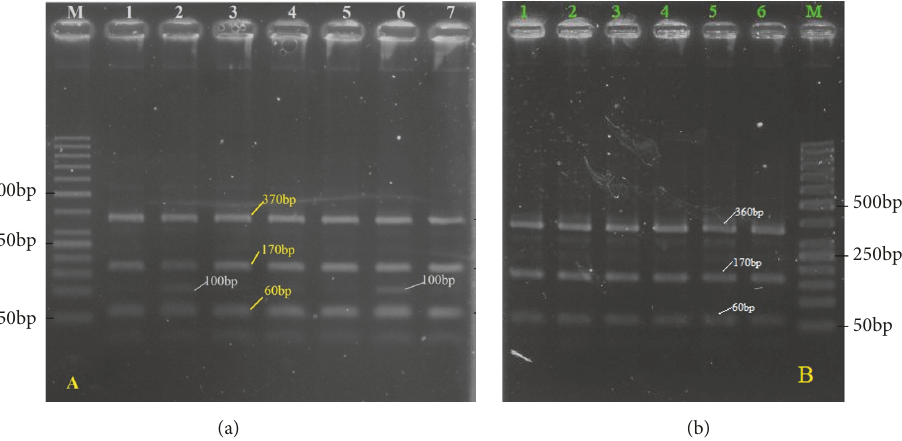
Figure3:RFLPpatternofPCRproductsofliverflukescollectedfrombovine(a)andbuffalo(b)inNgheAnprovince,Vietnam,afterdigestion with Rsa I enzyme. Lane M: 50 bp ladder molecular weight marker; lanes 1, 3, 4, 5, and 7 (a) denoted to those of F. gigantica ; lanes 2 and 6 (b) denoted to those of Fasciola sp. (intermediate form); lanes 1-6 (b) denoted to those of F.